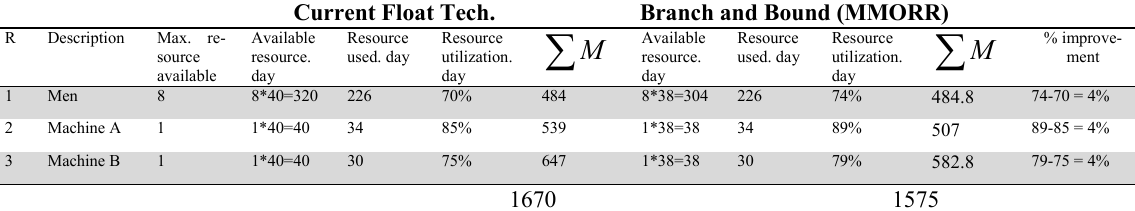
Comparison between Current Float Tech. and the new model B & B (MMORR) Current Float